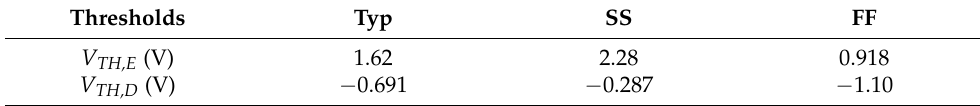
Table 1. Threshold spread in SS and FF corners (room